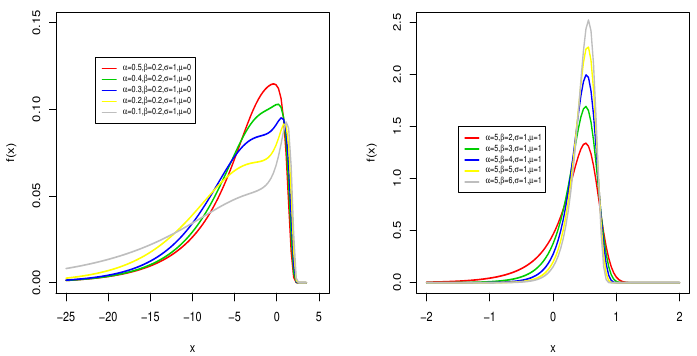
Figure 5. The pdf plots of the LAOLLOW-W